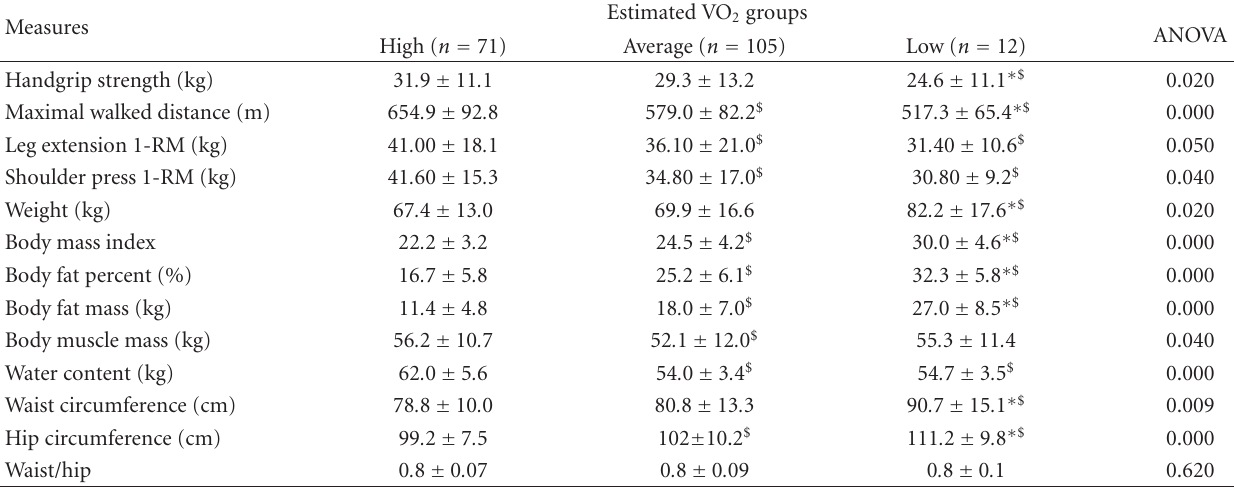
Table 4: Physical capacity and body composition measures in the high, average, and low estimated VO 2 groups.